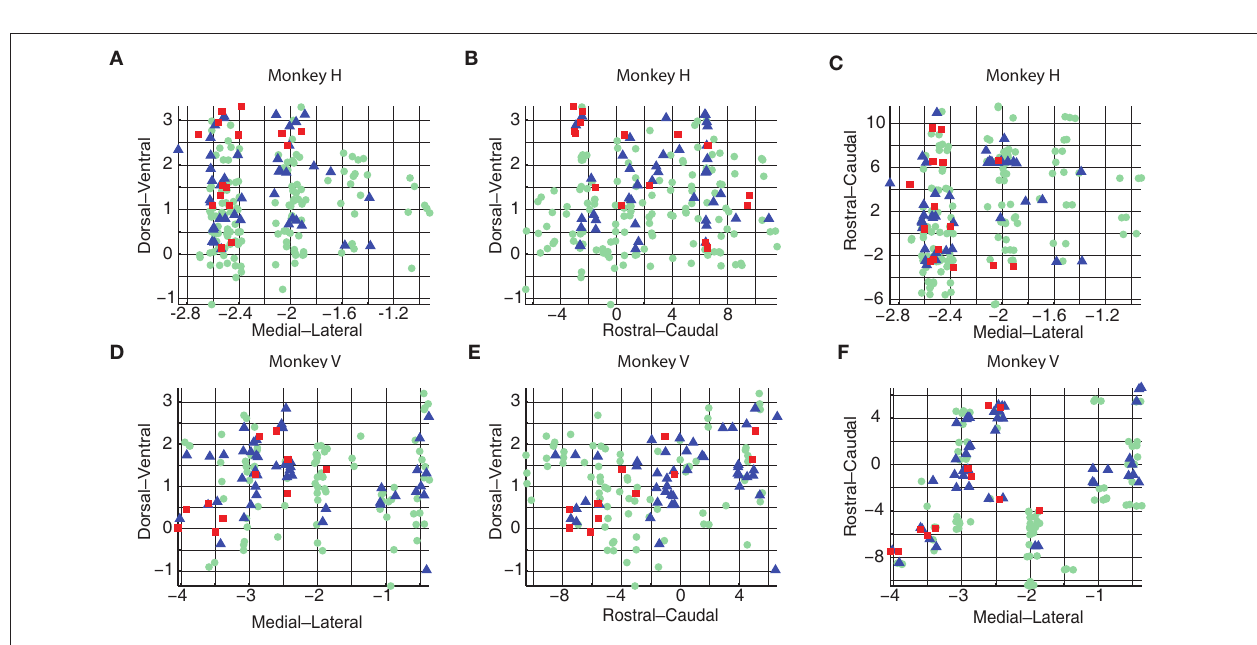
Figure 3 | AVPSD method. Distributions of power differences in a frequency range of 0–250 Hz. The histograms were then binned into three non-overlapping groups (indicated by red dashes). ( A) Histogram obtained for monkey H. ( B) Histogram obtained for monkey